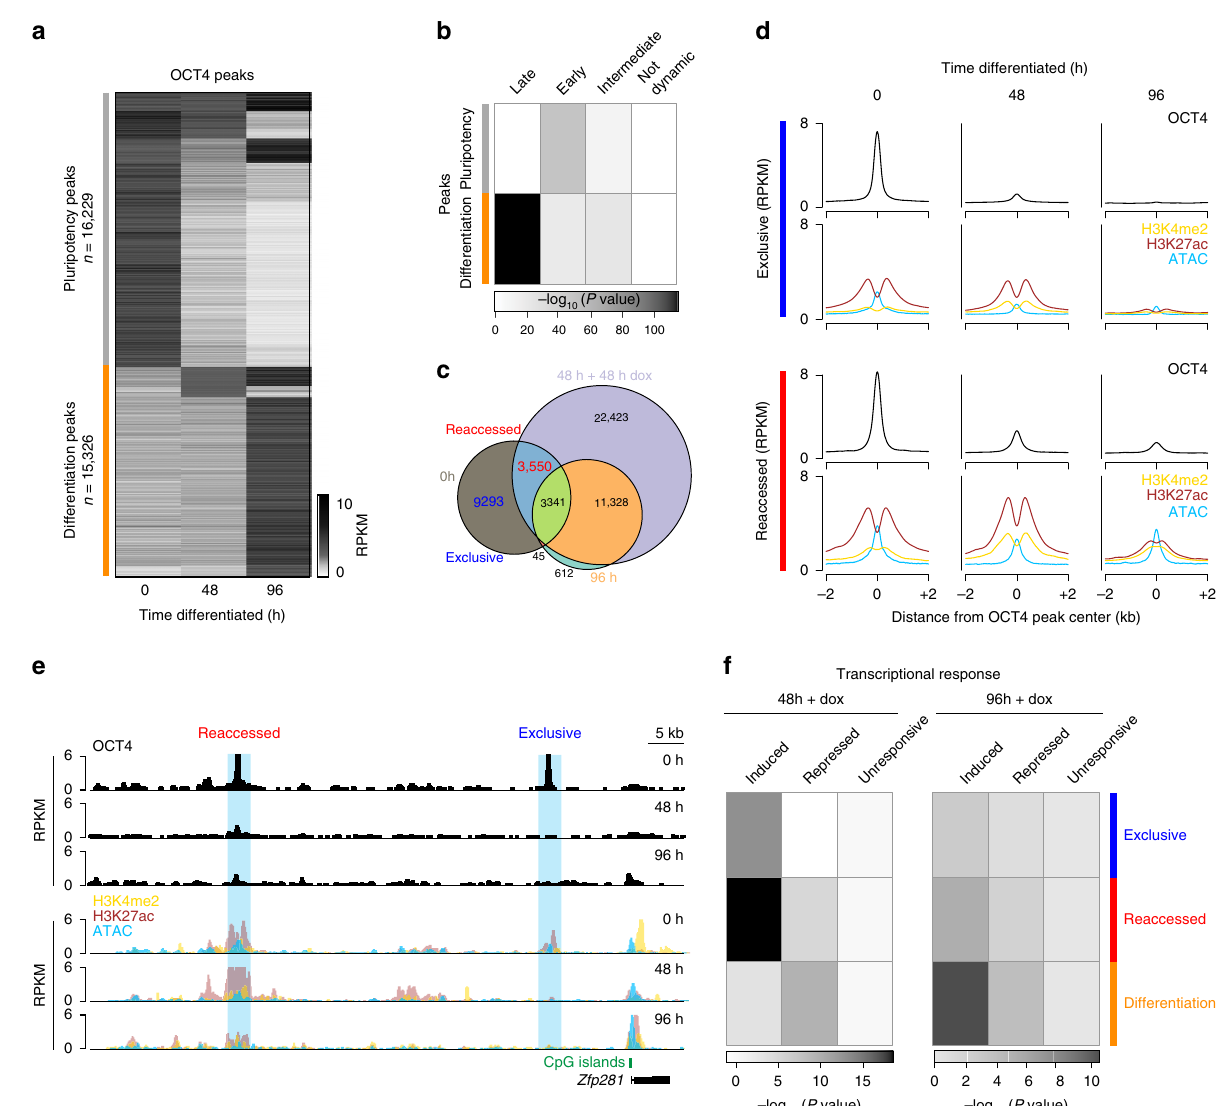
Fig. 4 OCT4-binding dynamics distinguish several classes of gene regulatory elements. a Heatmap of 31,555 high-con fi dence OCT4-binding peaks that show dynamic changes over undirected differentiation (2-fold change between any two timepoints). Dynamic peaks were sorted based on OCT4 enrichment at 0, 48, and 96 h, separating them into pluripotency ( n = 16,229) or differentiation ( n = 15,326) associated peaks. RPKM: Reads per kilobase per million. Each timepoint consists of two replicates. b Heatmap of the statistical overlap between transcriptionally dynamic genes and genes associated with either with pluripotency or differentiation peaks. P value is calculated by the hypergeometric test and displayed in log 10 . c Venn diagram of OCT4 peaks from iPSCs (0h; gray), the 96 h differentiated cells (orange), and cells exposed to dox for 48 h after 48 h of differentiation (light blue, 48 h + 48 h dox). Most pluripotency-associated OCT4 targets are not shared with the 96 h or 48 h + 48 h dox timepoints (pluripotency-exclusive: “ exclusive ” , n = 9293 of 16,229 0 h peaks). A subset of pluripotency-associated sites (pluripotency-reaccessed: “ reaccessed ” ; n = 3,550) are accessed by OCT4 in the 48 h + 48 h dox sample (see also Supplementary Fig. 3a). RPKM Reads per kilobase per million. d Composite plots of OCT4 occupancy (black) and chromatin state at 0, 48, and 96 h differentiation timepoints for exclusive (top) and reaccessed (bottom) OCT4 targets. Chromatin state includes: H3K4me2, yellow; H3K27ac, dark red; and chromatin accessibility as measured by ATAC-seq, blue. Lines represent the median enrichment for each set within ±2 kb of the peak center. Each time-point consists of two replicates. e Genome browser tracks of OCT4 enrichment at the Zfp281 locus. Top: OCT4 enrichment over differentiation (black). Bottom: selected chromatin dynamics (H3K4me2, yellow; H3K27ac, red; ATAC, blue). f . P value heatmap of the statistical overlap between genes that are induced, repressed, or unchanged (unresponsive) upon OSKM induction after 48 or 96 h differentiation, and genes closest to each of the three dynamic peak classes. Peaks were assigned to nearest protein-coding gene, with no upper bound on distance. P value for overlap signi fi cance is calculated by the hypergeometric